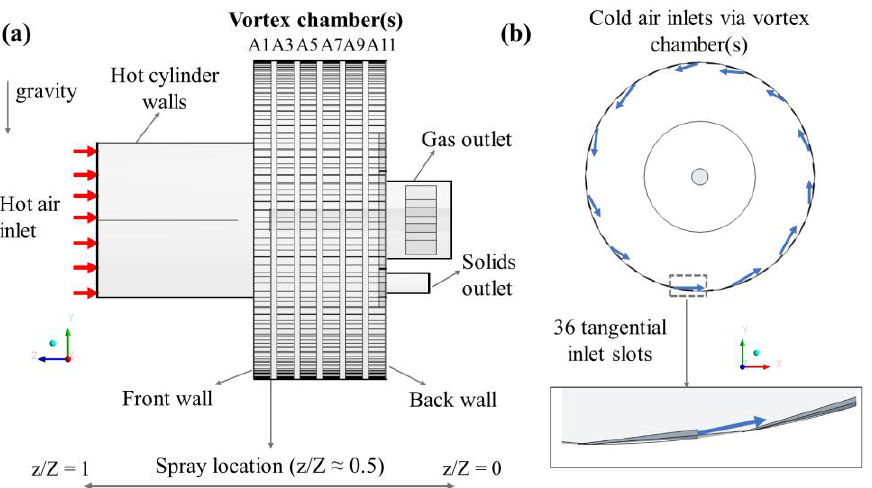
Figure 2. Computational domain of a Radial Multizone Dryer: ( a ) side view; ( b ) front view of a single wheel of the vortex chamber with 36 tangential inlets.